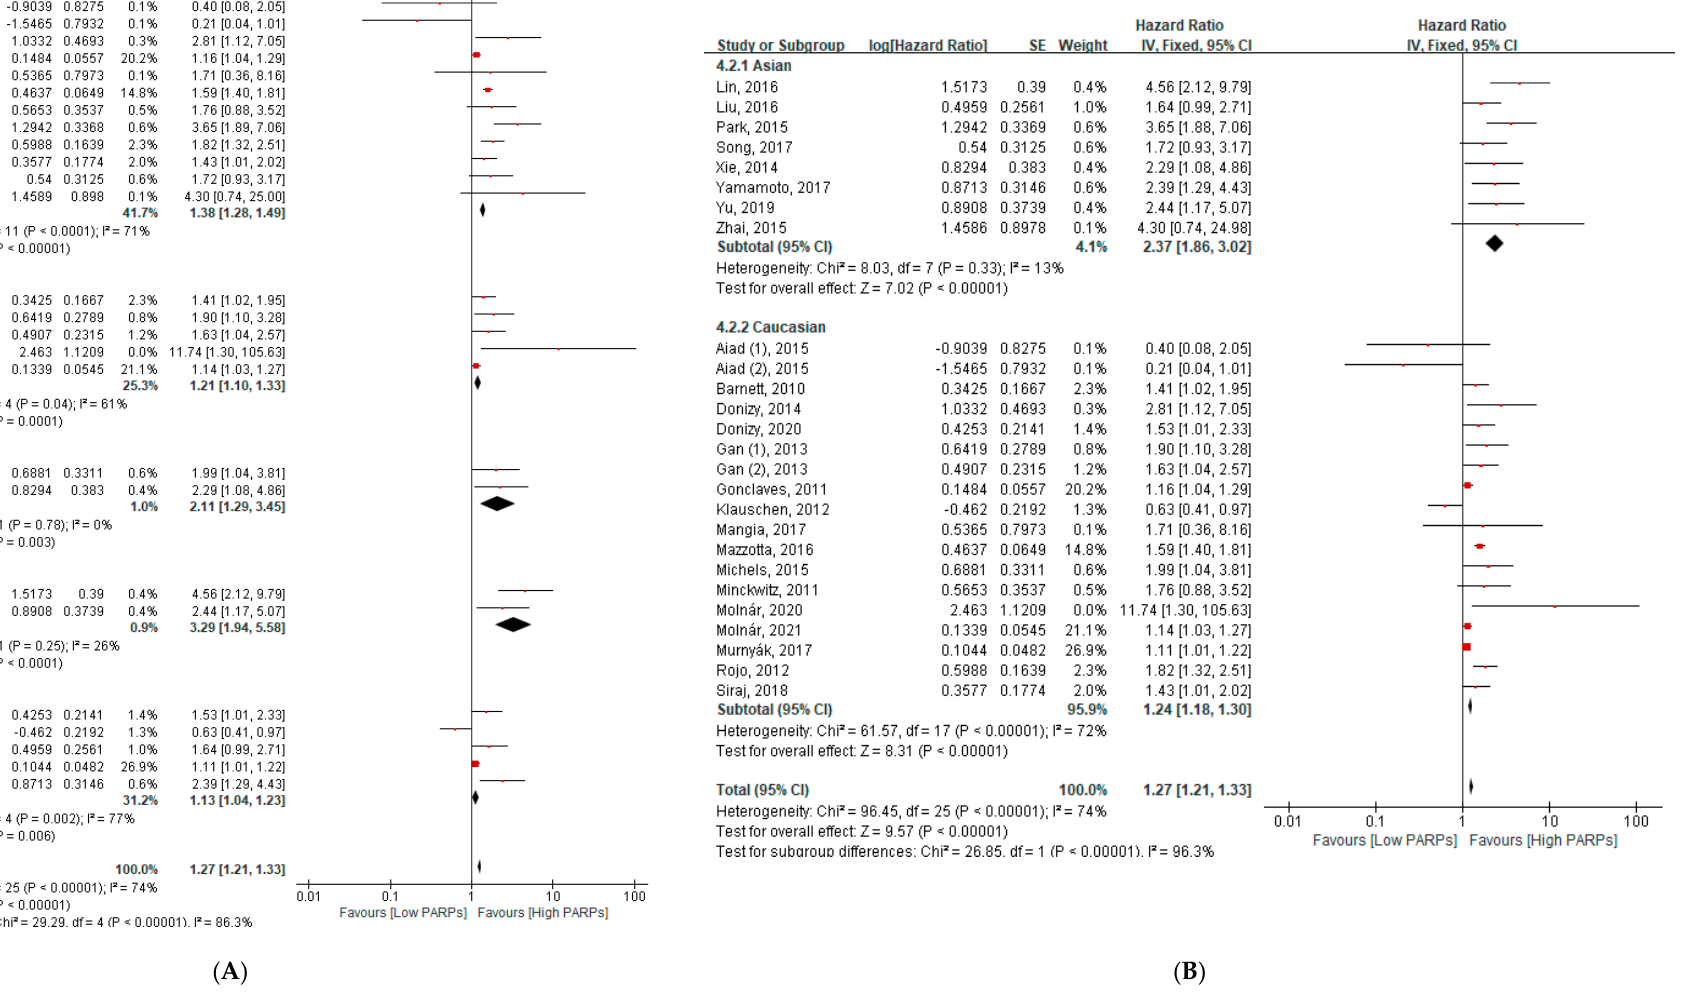
Figure 3. The subgroup analysis between the PARP expression and overall survival ( A ) according to the types of cancers and ( B ) ethnicity.